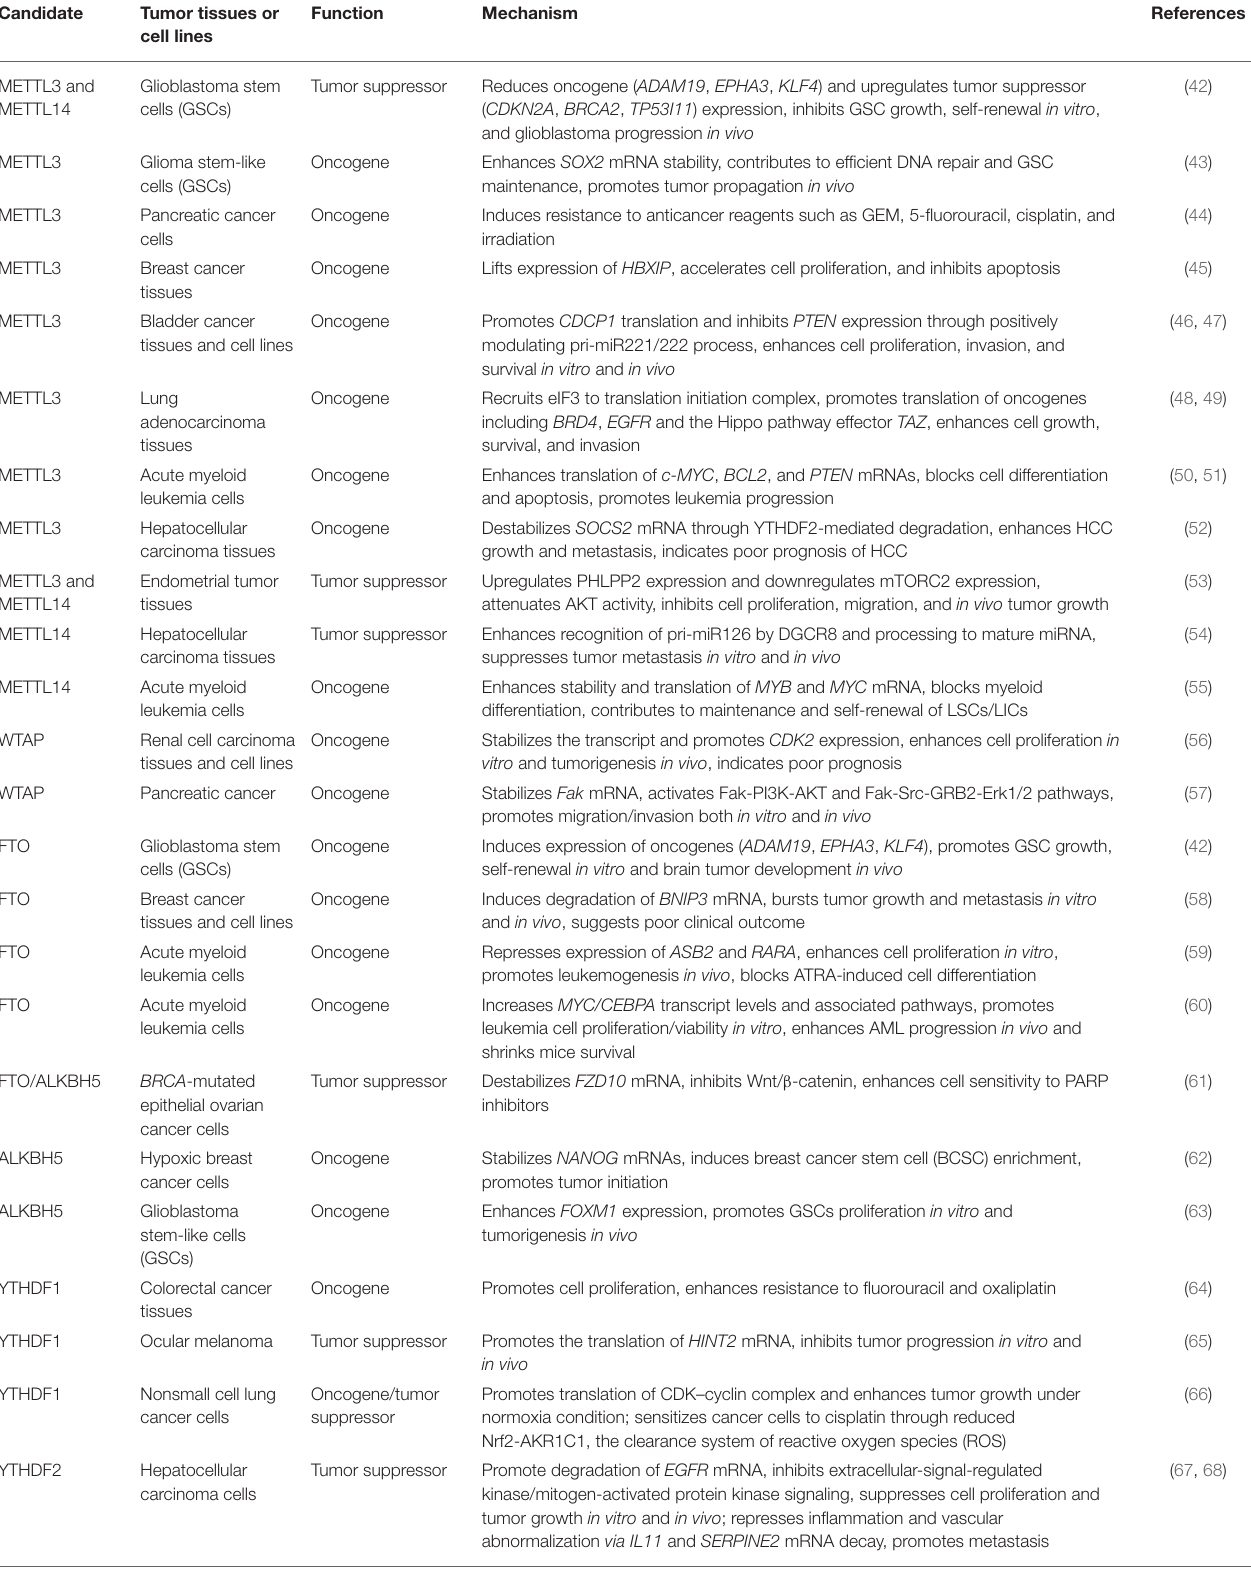
TABLE 1 | The summary of roles of m 6 A subunits in tumor formation and progression.